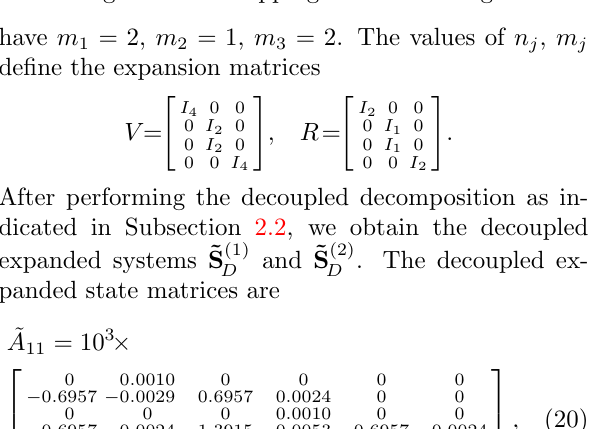
Figure 7: Overlapping controller